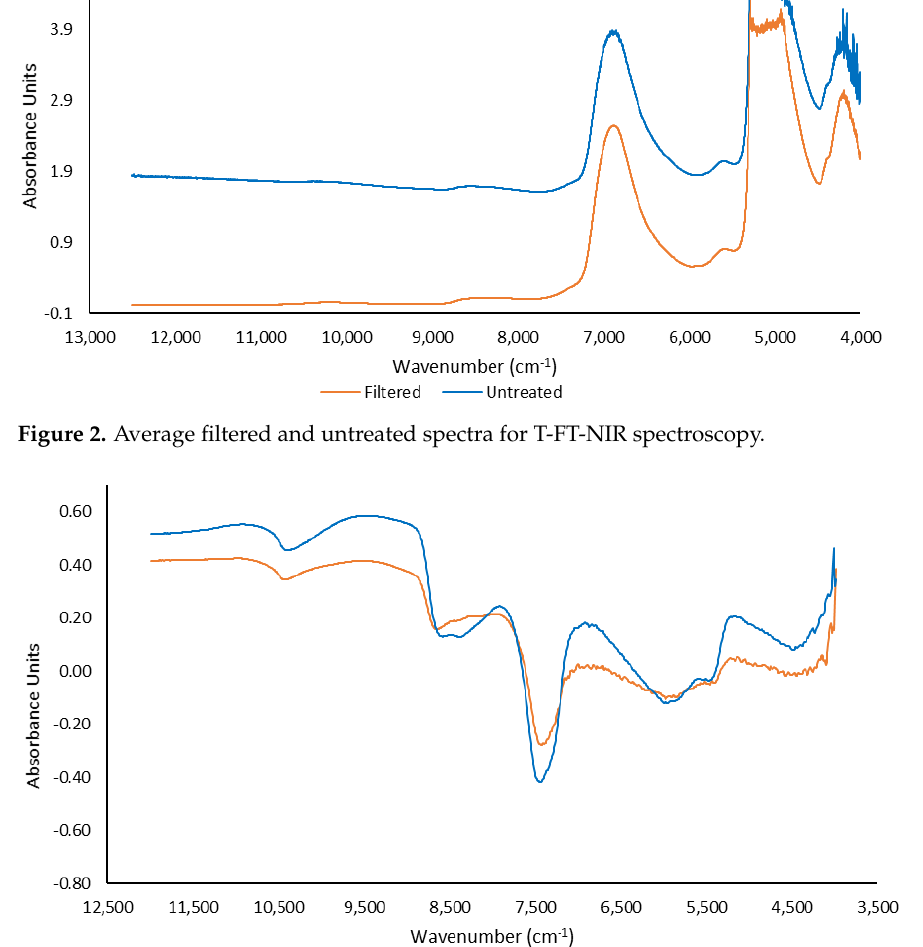
Figure 2. Average filtered and untreated spectra for T-FT-NIR spectroscopy.